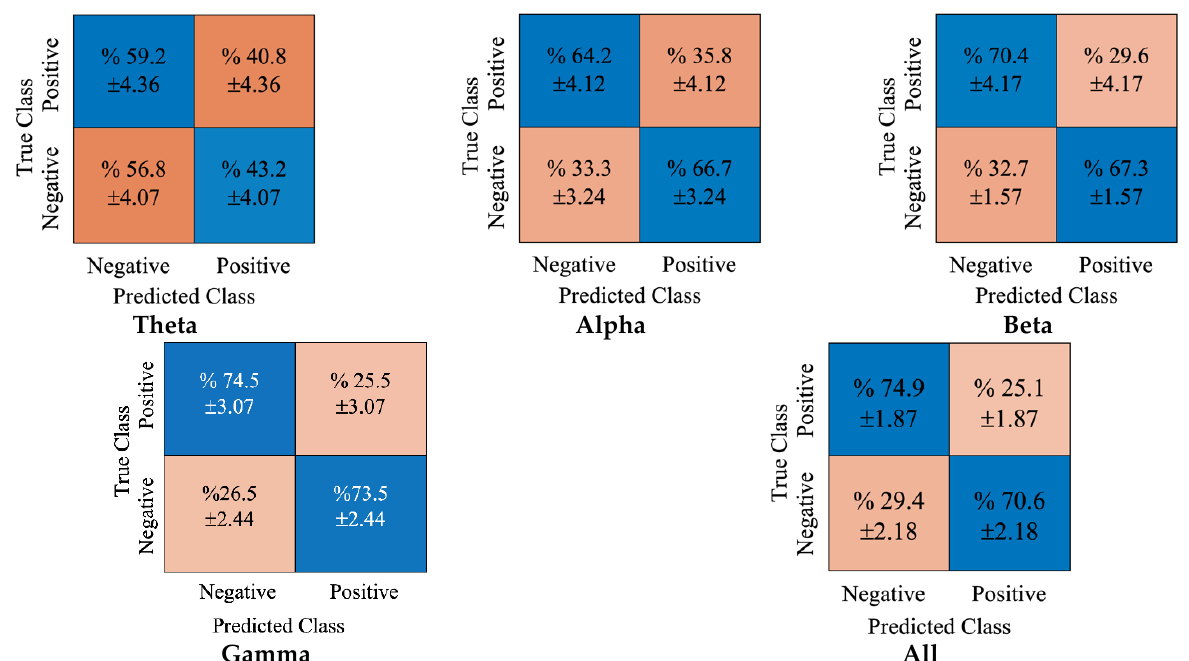
Figure 6. The obtained confusion matrices for DE features and kNN classifier. Similarly, Figure 7 shows the obtained confusion matrices for the NB classifier. Again, the true classification accuracies for positive and negative classes for the gamma rhythm were 60.4% and 59.2%, respectively.